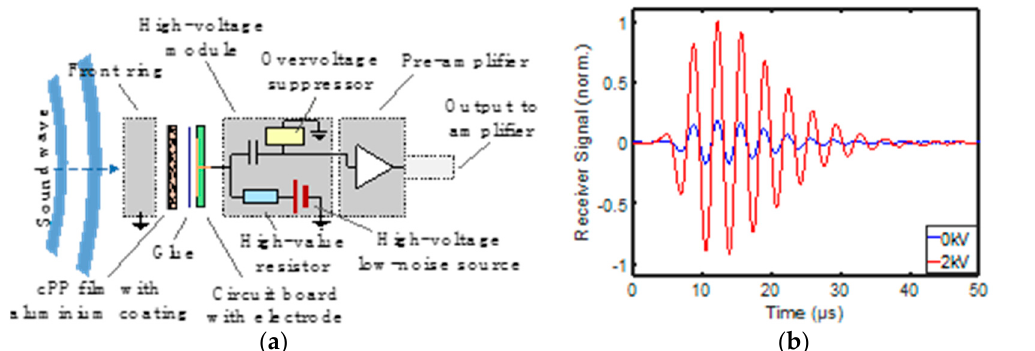
Figure 2. ( a ) Receiver with a high-voltage module that adds an external bias-voltage V dc to the existing internal voltage V 0 of the ferroelectret film. ( b ) Receiver signals with a bias-voltage V dc of 0 V (blue) and 2000 V (red).